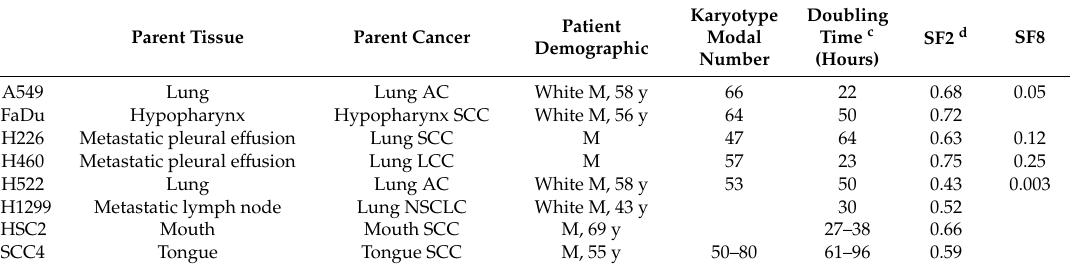
Table 1. Characteristics of the head and neck, and lung cancer cell lines used in this study a,b